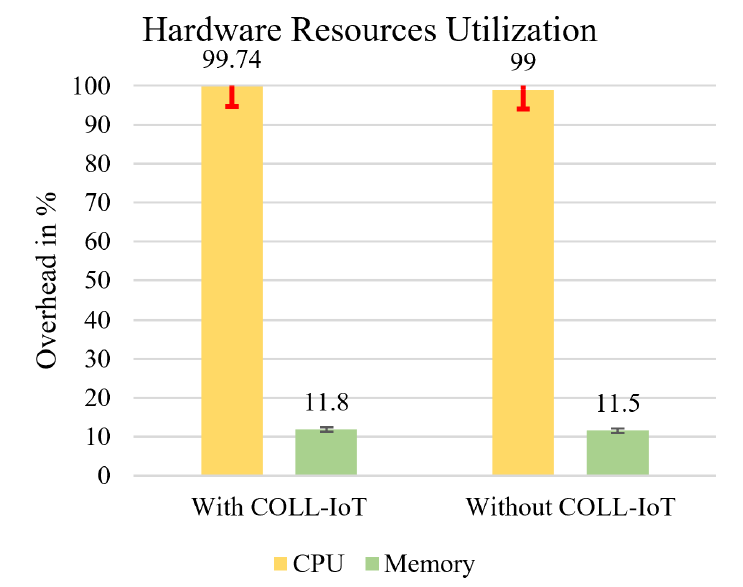
Figure 13. Hardware Resource